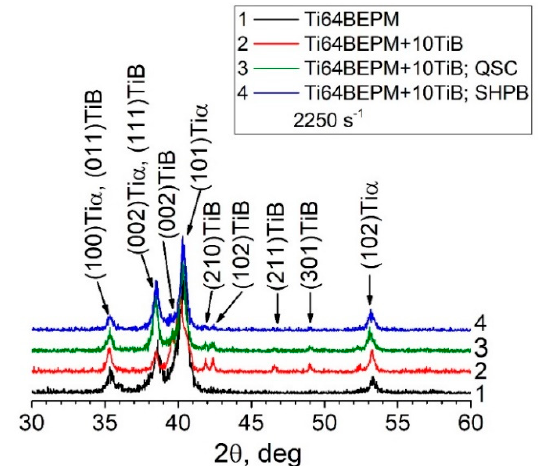
Figure 15. The X-ray diffraction patterns of (curve 1) Ti64BEPM, and Ti64BEPM + 10TiB in (curve 2) as-sintered state, and after QSC ( 𝜀(cid:4662) = 10 − 3 s − 1 ) (curves 3 and 4), and SHPB ( 𝜀(cid:4662) = 2250 s − 1 ) tests.